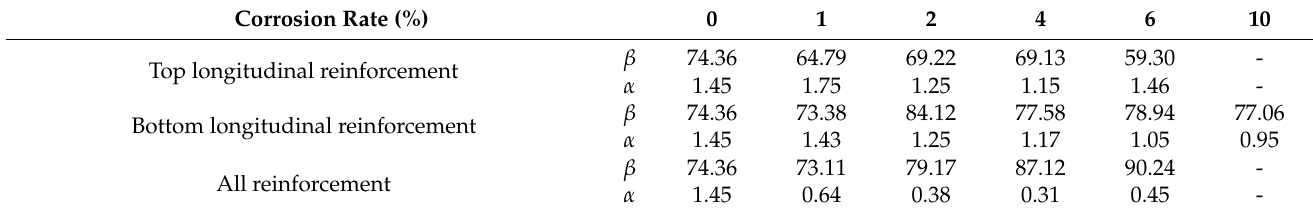
Table 3. Variation of β and α with rust rate for beams under different rust